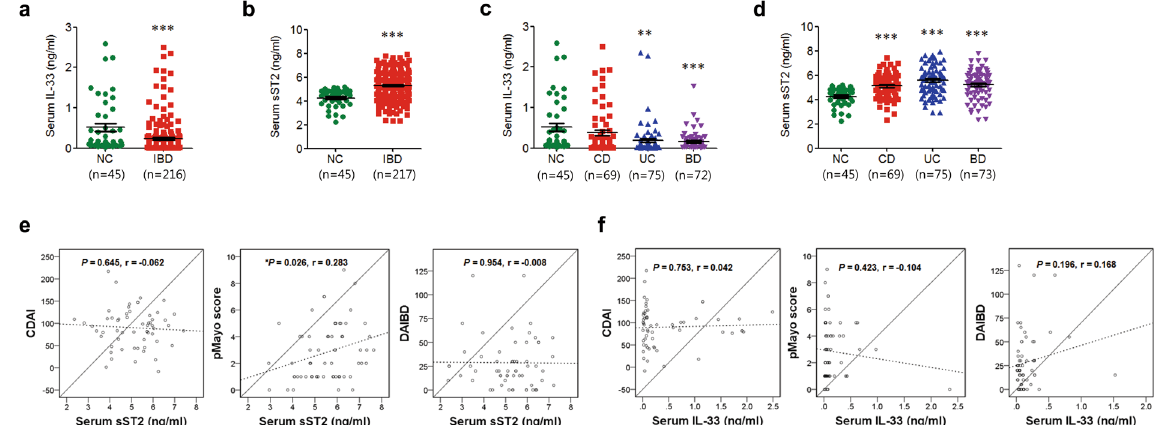
Figure 1. Levels of circulating IL-33 and soluble ST2 (sST2). Serum IL-33 and sST2 concentrations were determined in duplicate by enzyme-linked immunosorbent assay (ELISA). Two different anti-IL-33 antibodies were used, each of which recognized a different IL-33 epitope. The levels of IL-33 ( a , c ) and sST2 ( b , d ) were assessed by ELISA in serum samples from normal controls (NC) and patients with Crohn’s disease (CD), ulcerative colitis (UC), and Behçet’s disease (BD). The error bars represent the SEMs. ( e , f ) Correlations between serum IL-33 ( e ) and sST2 ( f ) levels and clinical disease activity of inflammatory bowel disease (IBD). ** P < 0.01 vs. NC, *** P < 0.005 vs. NC as assessed by ANOVA. NC, normal control; CDAI, Crohn’s disease activity index; DAIBD, disease activity index for intestinal Behçet’s